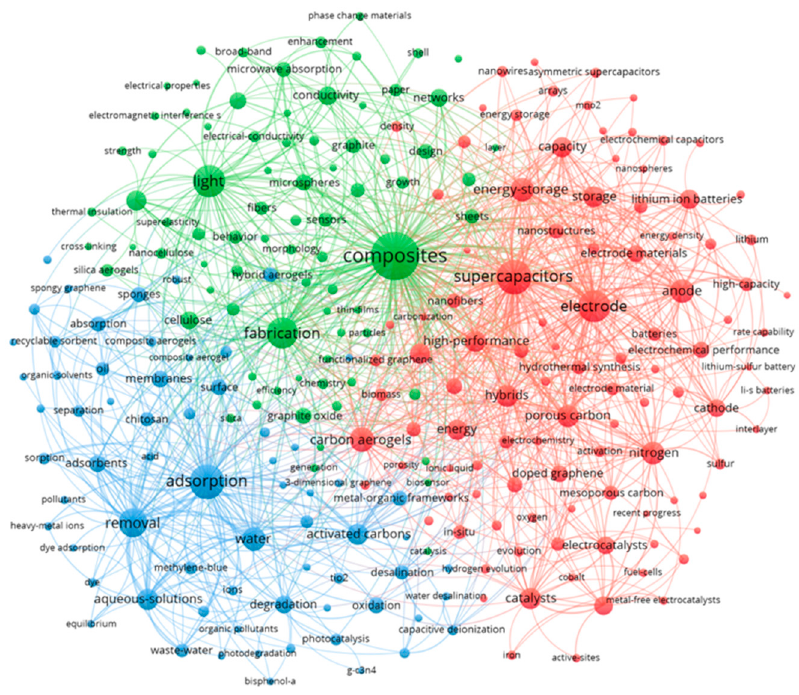
Figure 2. Summary network diagram of GA’s bibliometric analysis. Keyword co-occurrence analysis with at least 20 occurrences. The node size represents the occurrence frequency of the keywords. The same color represents relevance.